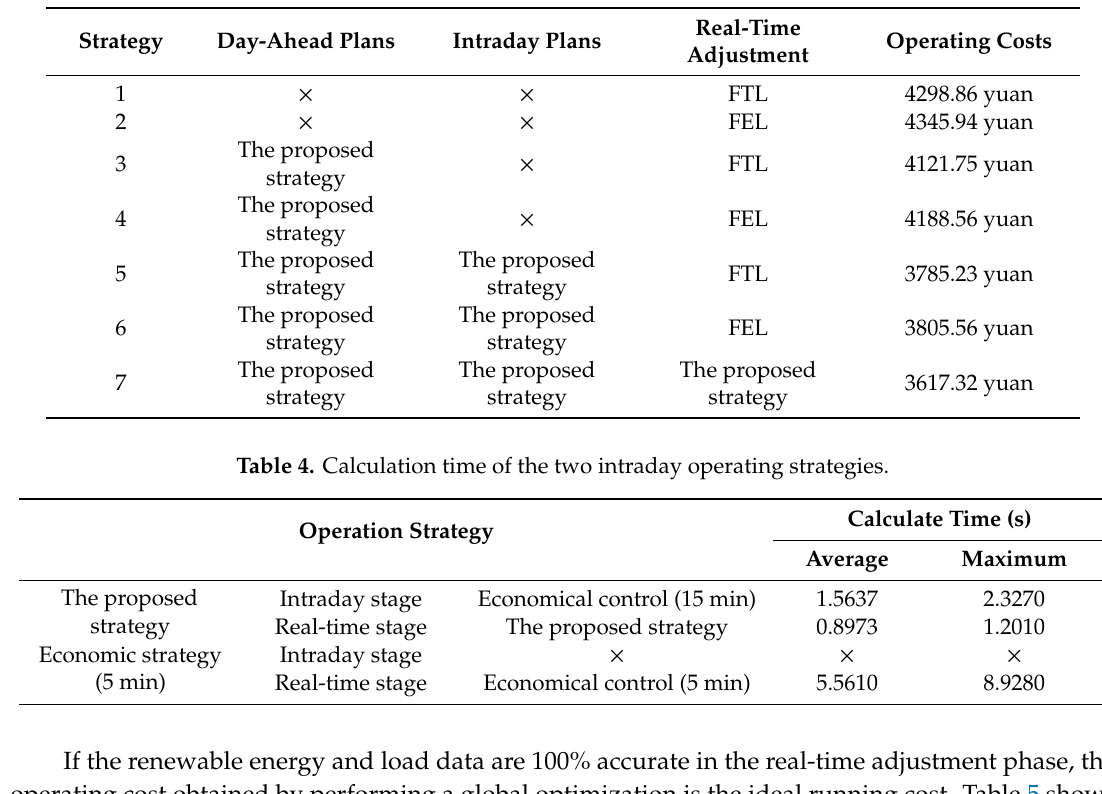
Table 3. Operating costs of the system under di ff erent multi-time-scale optimization strategies. FTL: following the thermal load; FEL: following the electric load.